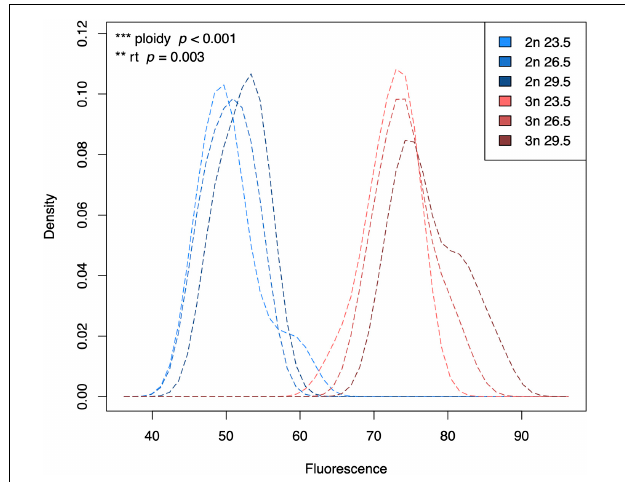
FIGURE 1 | Kernel density plot of the fluorescence of G1 phase cells of diploid and triploid larvae reared at different temperatures. Light, medium, and dark blue lines represent densities for diploid larvae reared at 23.5 ◦ C, 26.5 ◦ C, and 29.5 ◦ C, respectively. Light, medium, and dark red lines represent densities for triploid larvae reared at 23.5 ◦ C, 26.5 ◦ C, and 29.5 ◦ C, respectively. The density is scaled to 1 (100%), which does not have a unit. Fluorescence also does not have a unit, which is why we always add a standard when measuring fluorescence of our samples. Effects of rearing temperature and ploidy were significant (ANOVA, p = 0.003 and ANOVA, p < 0.001, respectively, n = 63).